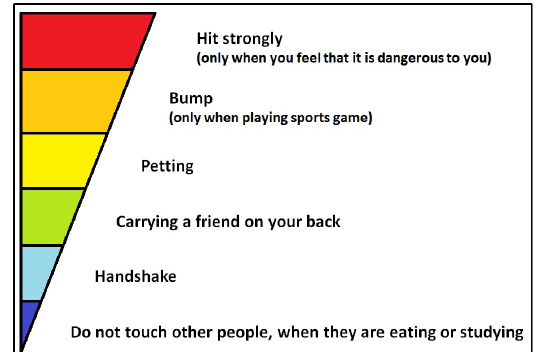
Fig. 2. Teaching material for touching with social